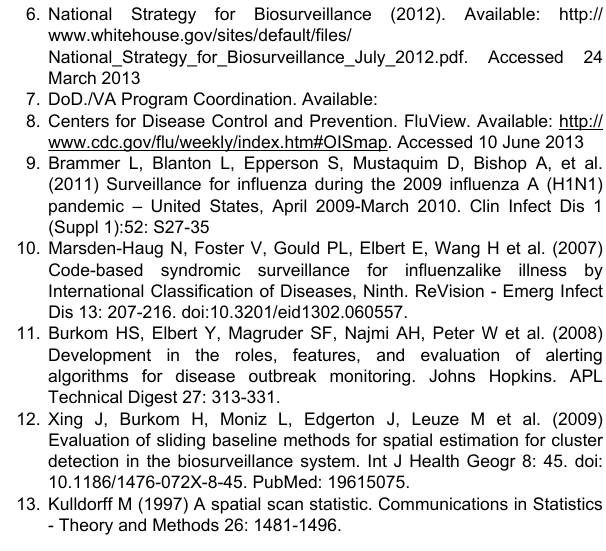
syndrome group analysis. Table S2 , Diagnosis code classification for gastrointestinal